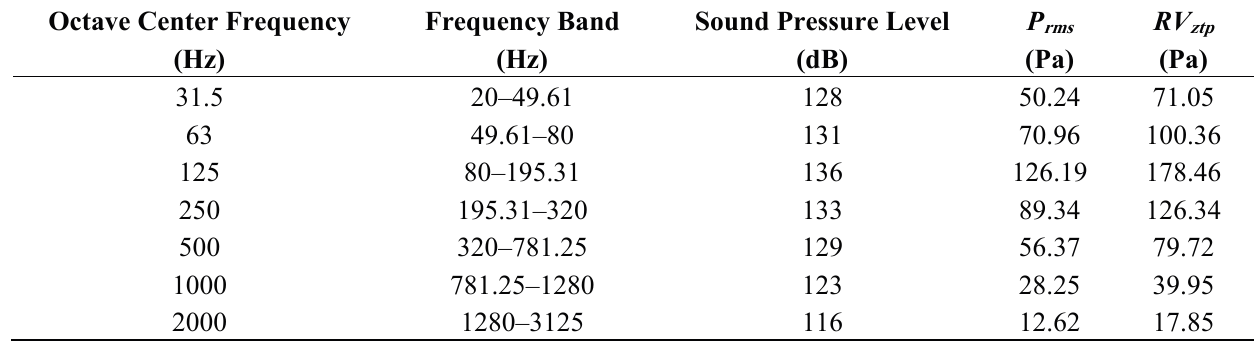
Table 4. Acoustic noise spectrum under the fairing of Arian